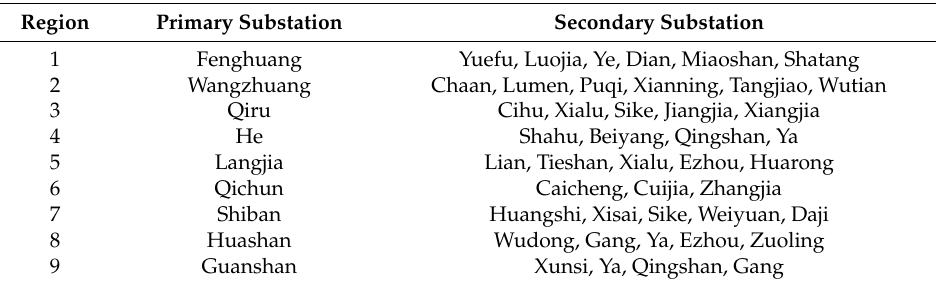
Table 5. Results of dividing into 9